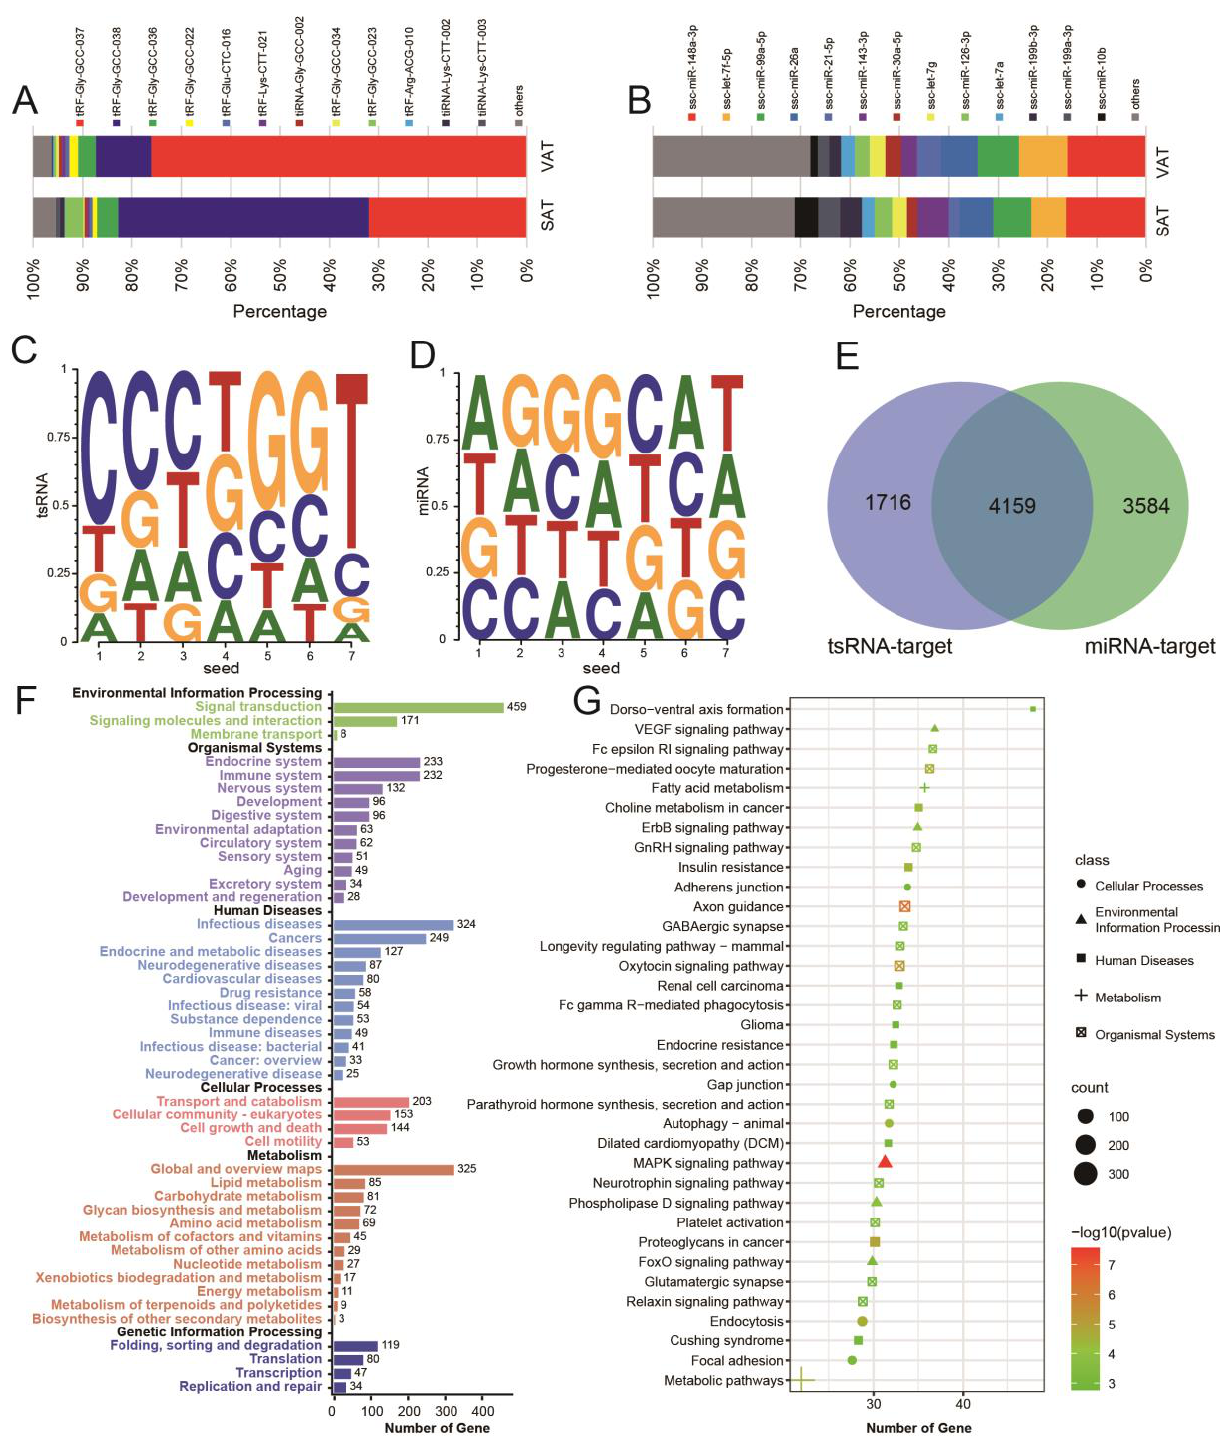
Figure 3. Enrichment analysis of tsRNAs and miRNAs target genes. ( A , B ) The proportion of highly expressed tsRNAs ( A ) or miRNAs ( B ). ( C , D ) Characteristics of tsRNA ( C ) or miRNA ( D ) Seed Sequences. ( E ) Venn map of target genes of tsRNAs and miRNAs. ( F , G ) Enrichment results of KEGG_B_classes ( F ) and pathways ( G ) of co-predicted target genes of tsRNAs and